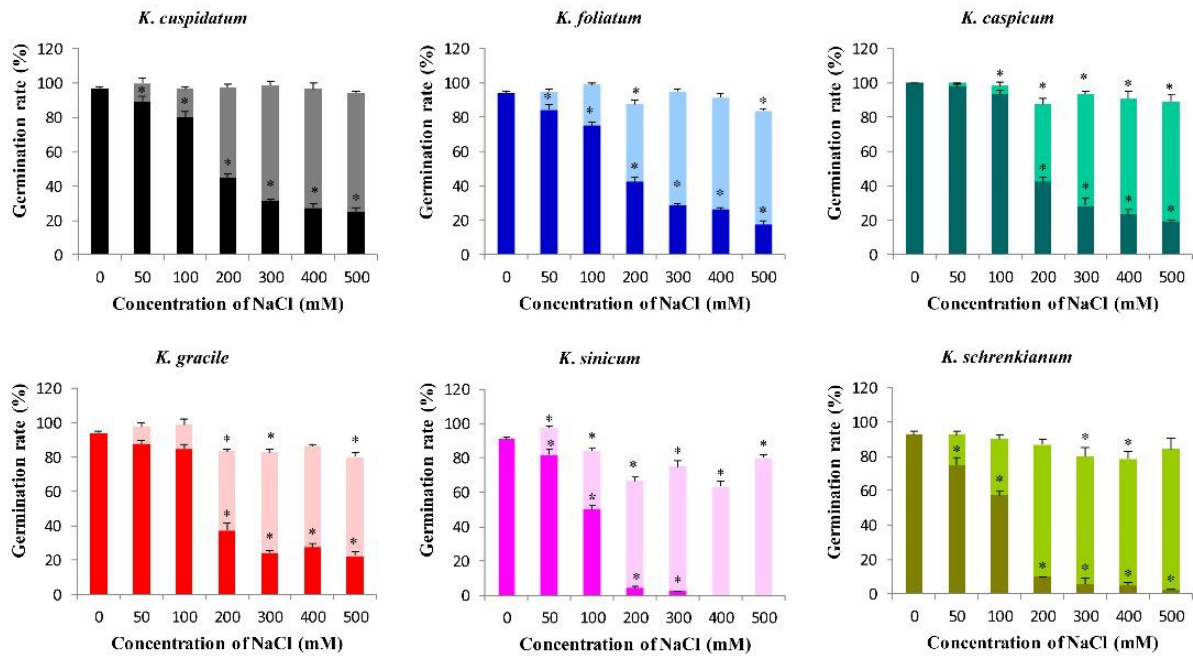
Figure 6. Total germination percentages after 14 days at the indicated NaCl concentrations in the six studied Kalidium species. Germination rates (%, means and standard deviations) of the six Kalidium species after treatments with indicated concentrations of NaCl (0, 50, 100, 200, 300, 400, and 500 mM NaCl) after 7 days. The dark bars indicate germination rates after the treatments and light bars the total percentages that germinated during the recovery treatment in distilled water with additional 7 days. Asterisks indicate significant differences in each condition respect to the corresponding control (according to Dunnet test, p < 0.05).